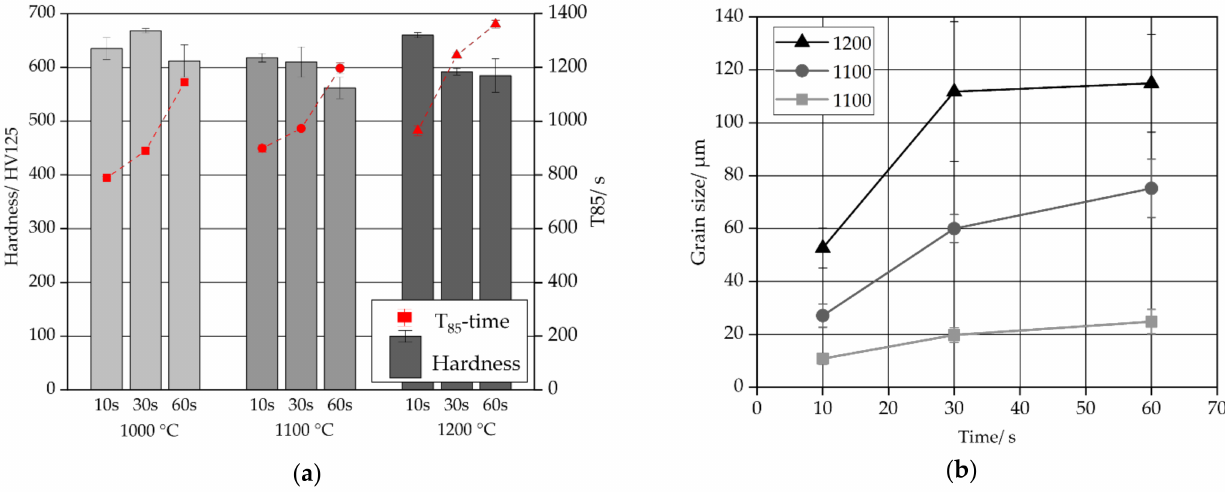
Figure 6. Comparison of the measured hardness of the surface and the corresponding T 85 -time ( a ) and comparison of the measured average grain size according to the DIN EN ISO 643 standard in the upper layer ( b